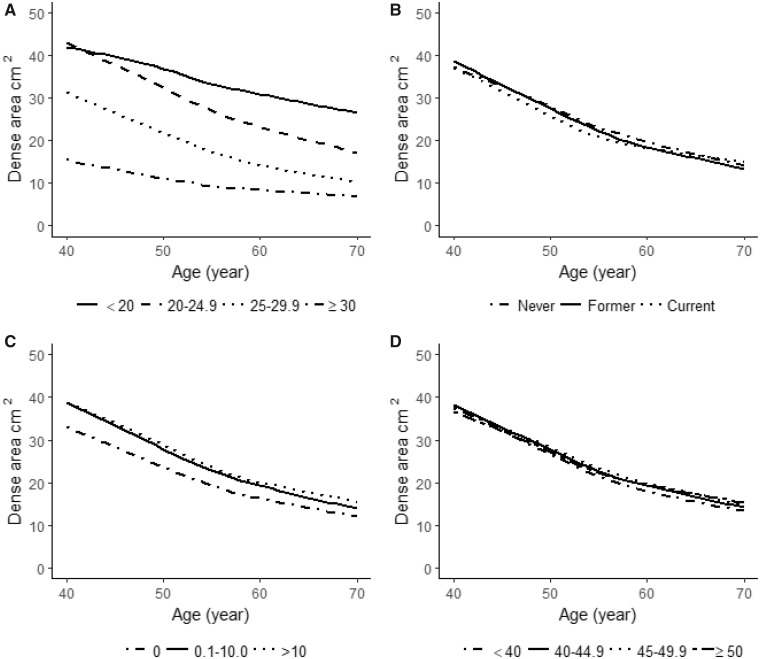
Mean baseline mammographic dense area (cm2) as a function of age at mammography screening and established lifestyle factors including: A) body mass index ( <20, 20–24.9, 25–29.9, ≥30 kg/m2), B) smoking status (never, former, current), C) alcohol consumption (0, 0.1–10.0, >10 g/d), and D) physical activity (<40, 40–44, 45–49.9, ≥50 metabolic equivalent of task-h/d) at study entry.